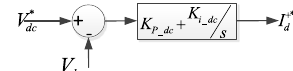
Fig. 3 Overall dc capacitor voltage